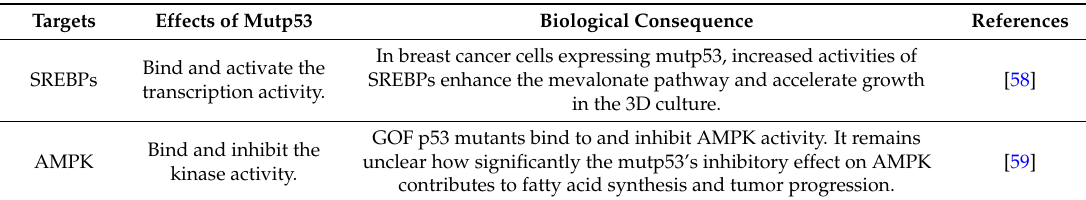
Table 2. Targets of mutant p53 in lipid